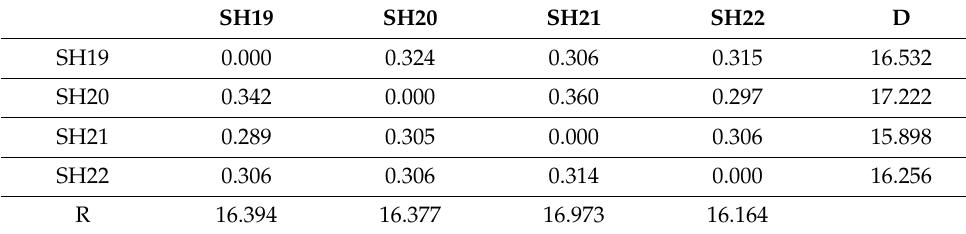
Table 10. Total influence matrix—human talent sub-criteria.